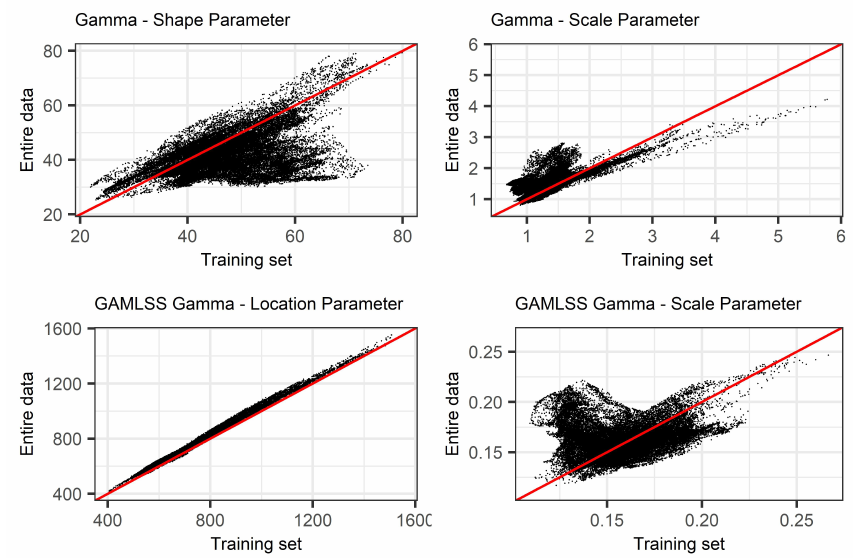
Figure 5. Comparison between the distribution parameter estimates of accumulated precipitation between Y ( 12 ) , ( k , l , m ) ( y -axis) and Y ( 12 ) , ( k ) ( x -axis) for 36,662 basins in Sweden during 1961–2018: ( top ) stationary SPI and ( bottom ) non-stationary